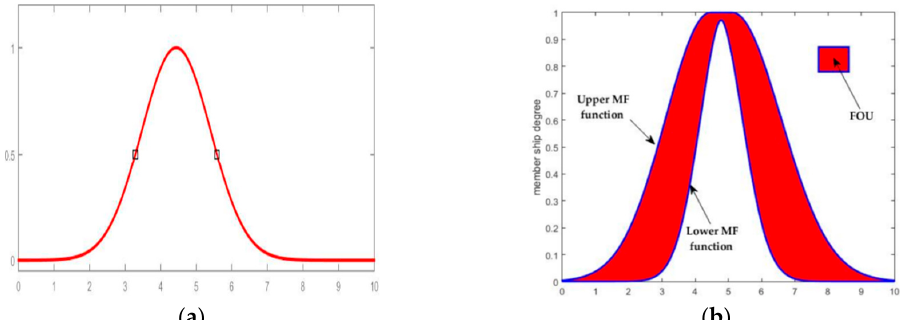
Figure 4. ( a ) Type-1 membership function and ( b ) type-2 membership function. Legend: FOU, footprint of uncertainty.